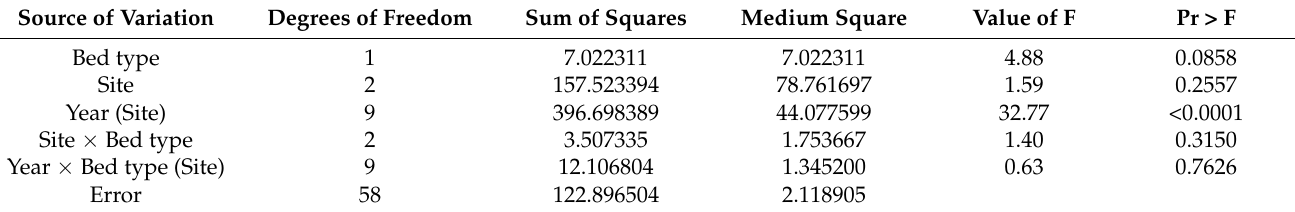
Table 5. Combined variance analysis for the maize yield variable in two bed types, under irrigated conditions. Source of Variation Degrees of Freedom Sum of Squares Medium Square Value of F Pr >